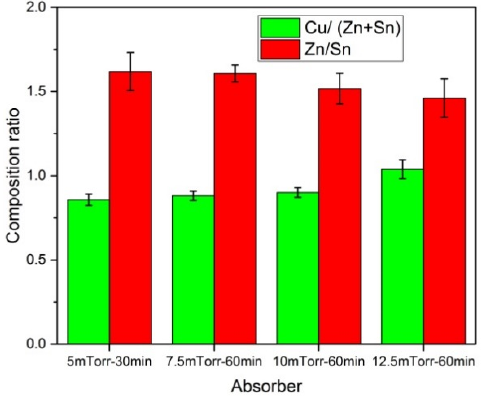
Figure 1. Chemical composition (atomic ratios of Cu/(Zn + Sn) and Zn/Sn) of sulfurized Cu 2 ZnSnS 4 (CZTS) absorbers with precursors deposited at different pressures and durations: 5 mTorr-30 min is the deposition condition: 50 mTorr pressure and 30 min duration.